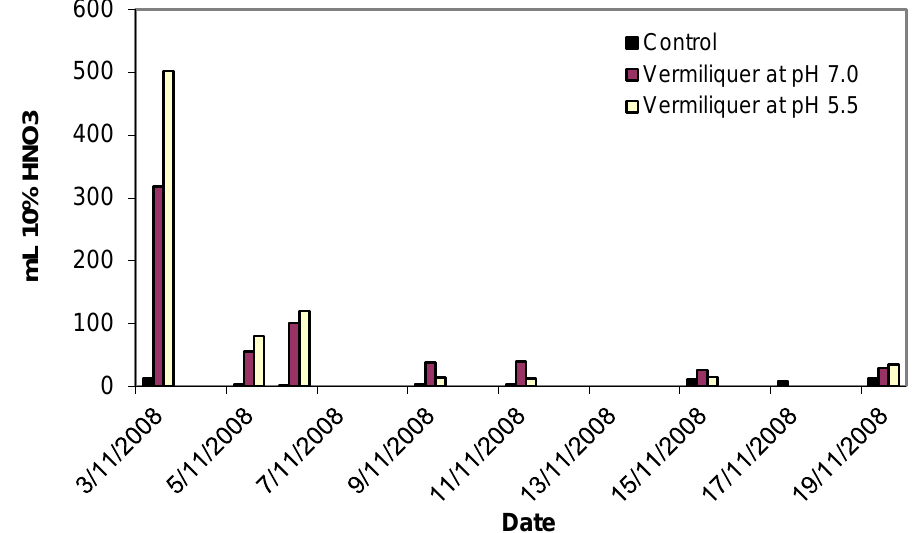
Figure 1. Quantity and timing of pH buffer (10% HNO 3 ) used in Study II to achieve different pH of vermiliquer nutrient solution, transplanted 31 October 2008.